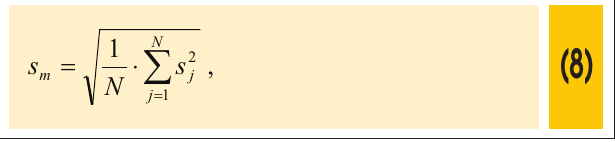
Figure 6 – Location of the points of the probe penetration tests in each of the cross sections measured in the